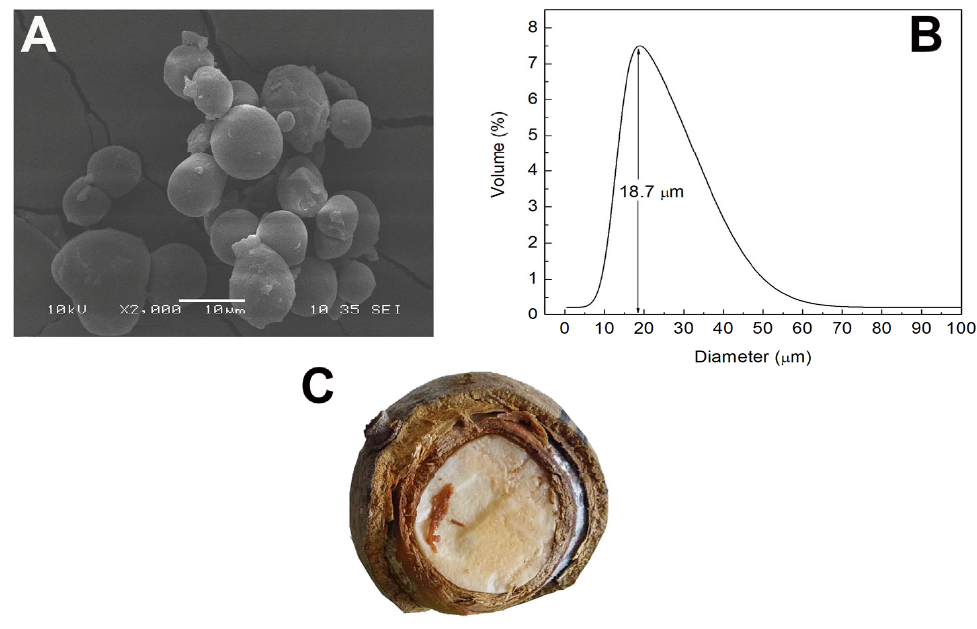
Figure 2. ( A ) Micrograph on colok starch. ( B ) Average size of colok granule. ( C ) Colok seed.